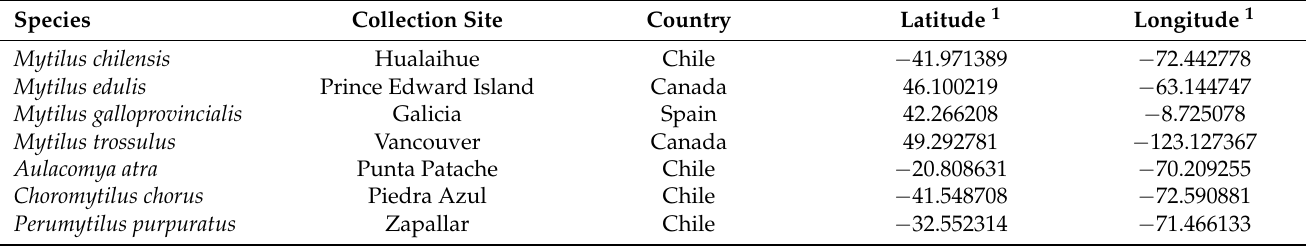
Table 1. Sampling location of individuals from natural populations, collection site, country and geographic coordinates.